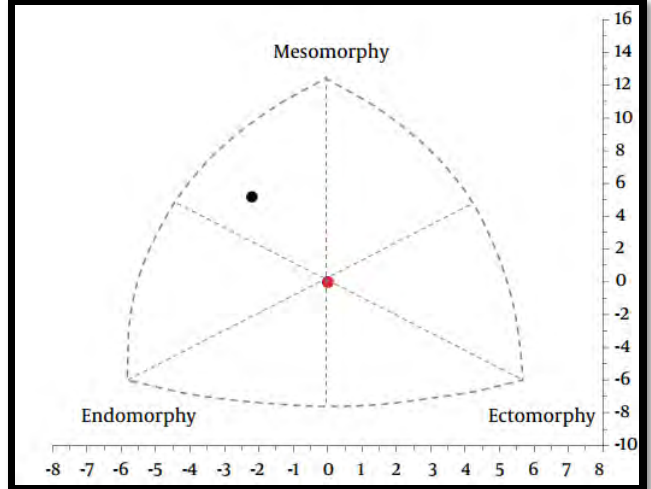
Figure 2. Somatotype average characteristics of Columbia wrestlers’ national team. O = somatotype mean (3.8 – 5.3 – 1.6),